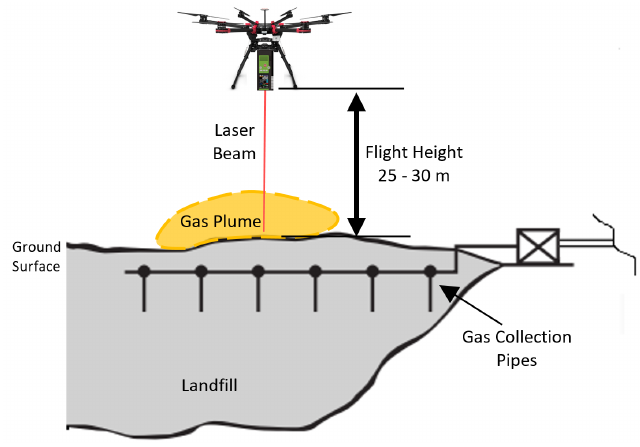
Figure 2. Methane detector mounted to the UAV collects gas concentration